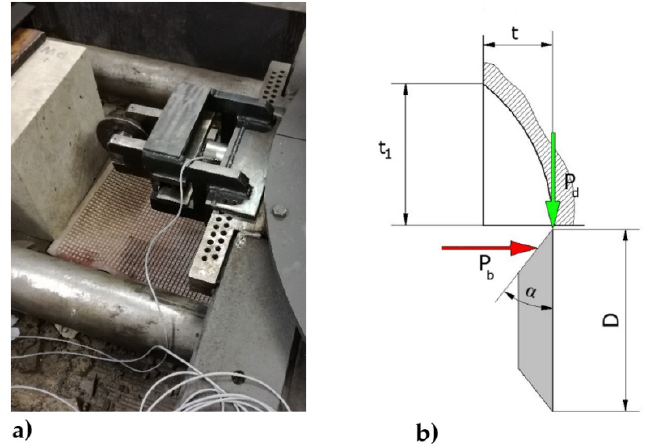
Figure 9. The view of laboratory stand for testing mining process with a single mini-disk tools—( a ) scheme of measured parameters during mining tests—( b ).